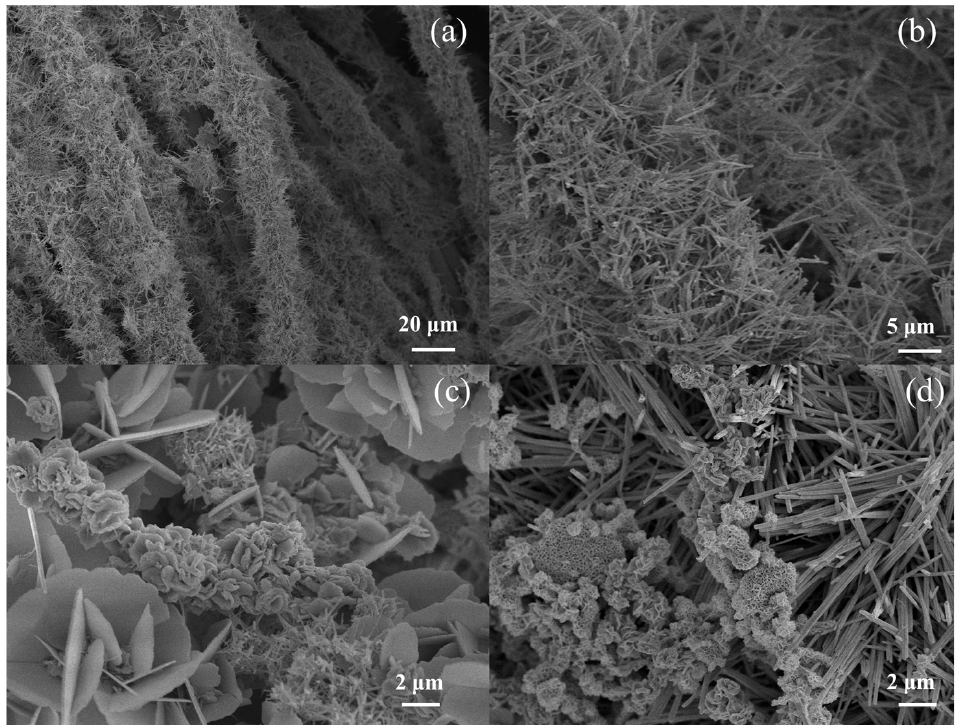
Figure 1. ( a , b ) SEM images of α -NiMoO 4 NWs/CC; ( c , d ) SEM images of Co(OH) 2 / α -NiMoO 4 NWs/CC.